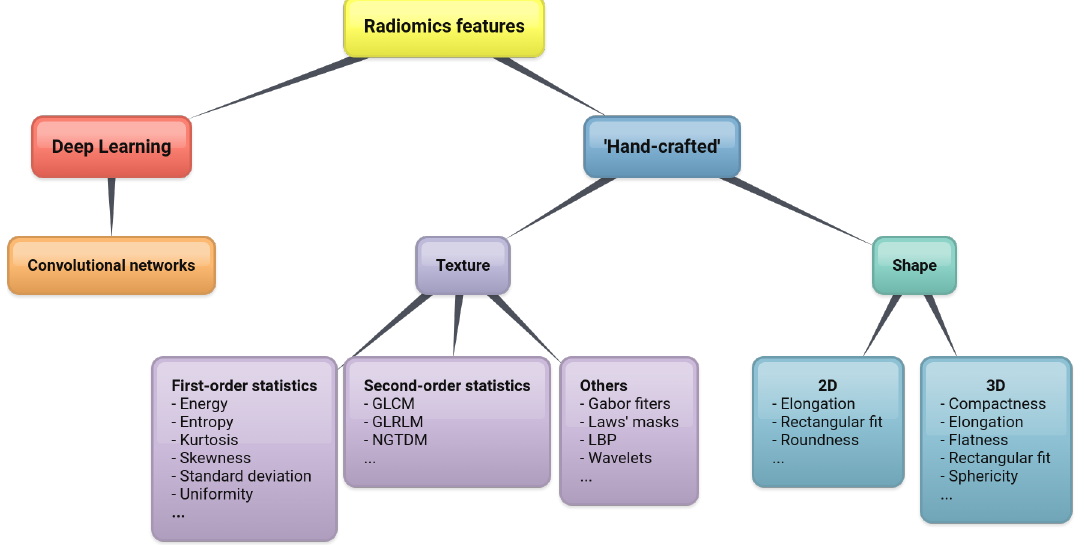
Figure 2. Radiomics features: a